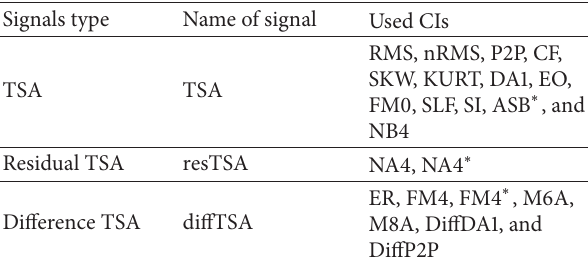
Table 1: Signals of interest and used